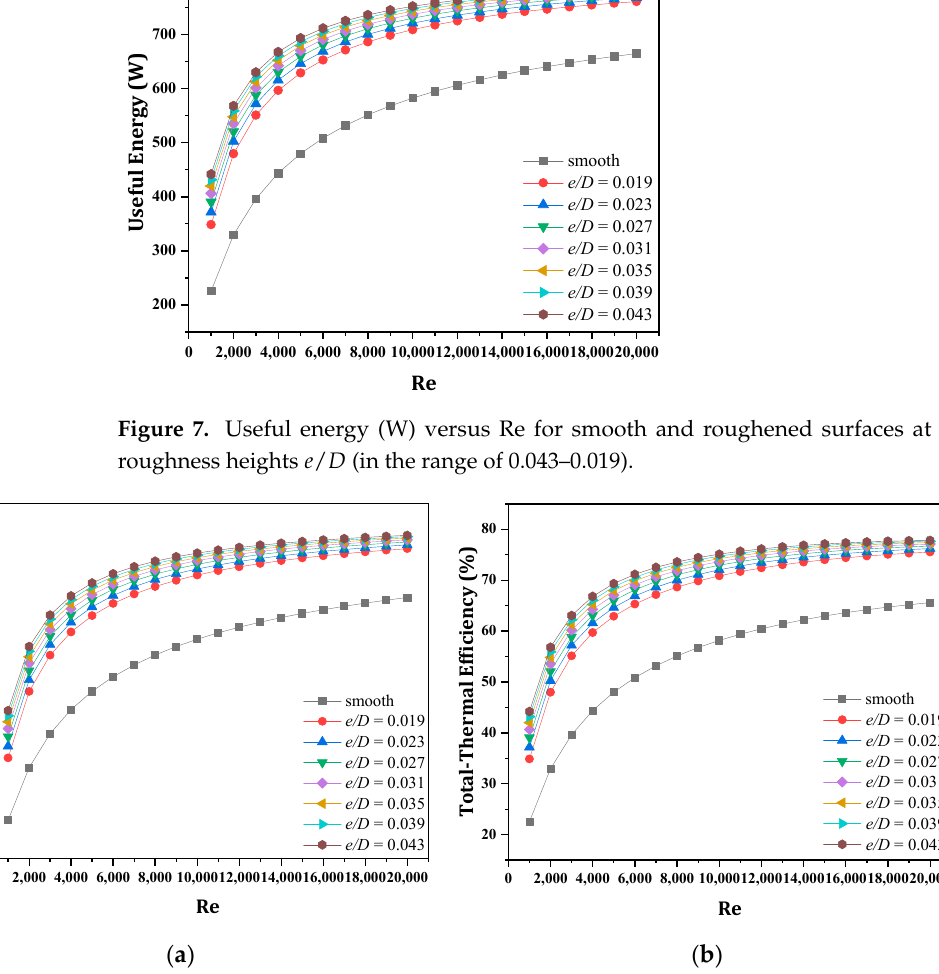
Figure 8. Thermal ( a ) and total thermal ( b ) efficiencies versus Re at smooth and roughened surfaces various relative roughness heights (in the range of 0.043 – 0.19 ).